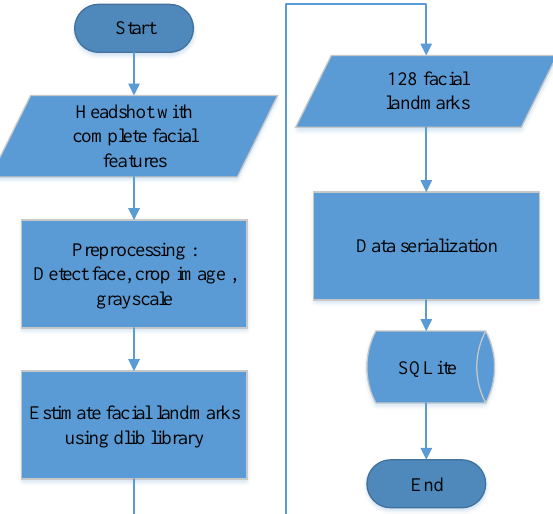
Figure 2. Flowchart showing the process of creating the student database in SQLite.